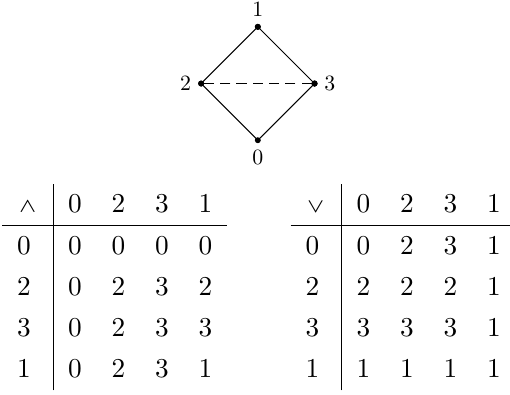
Fig. 1. The Caley tables and the admissible Hasse diagram of a right-handed skew